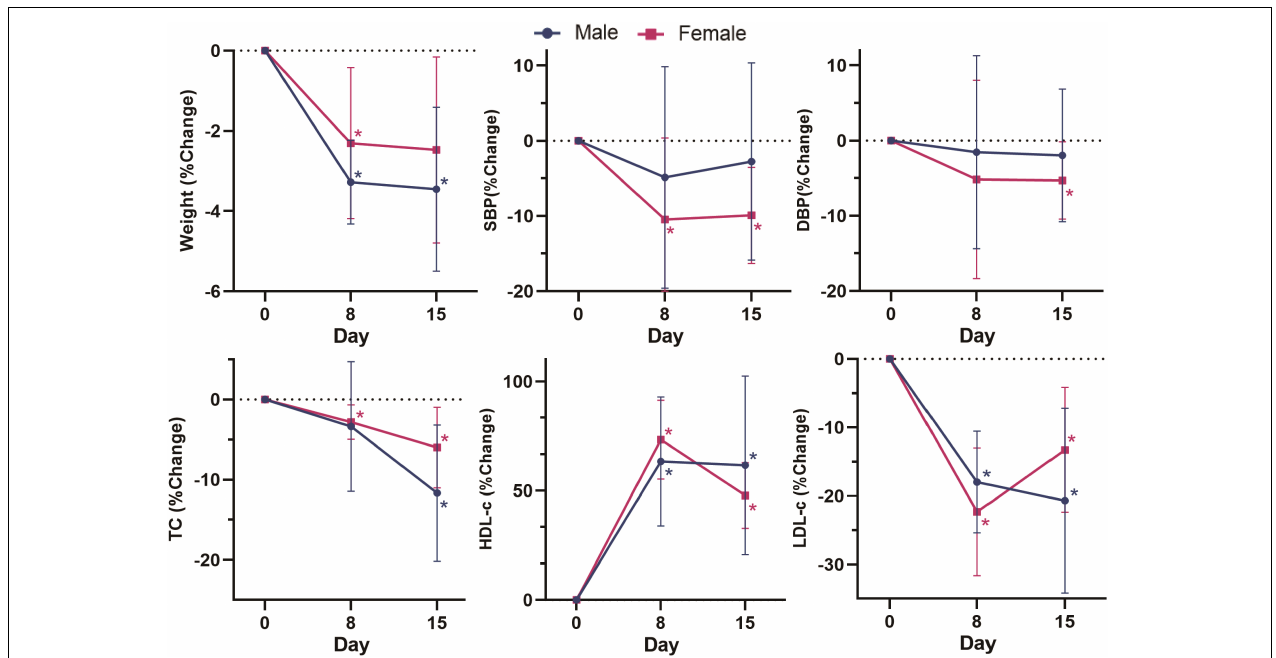
FIGURE 2 | Change (%) in weight, SBP, DBP, TC, HDL-c, and LDL-c in different sex groups on day 0, day 8 and day 15. Change (%) = (Indicators after intervention – Indicators before intervention) × 100%/Indicators before intervention. Data were shown by the percentage of reduction compared with baseline for the two groups. *: Significant difference compared with baseline. *: p < 0.05.